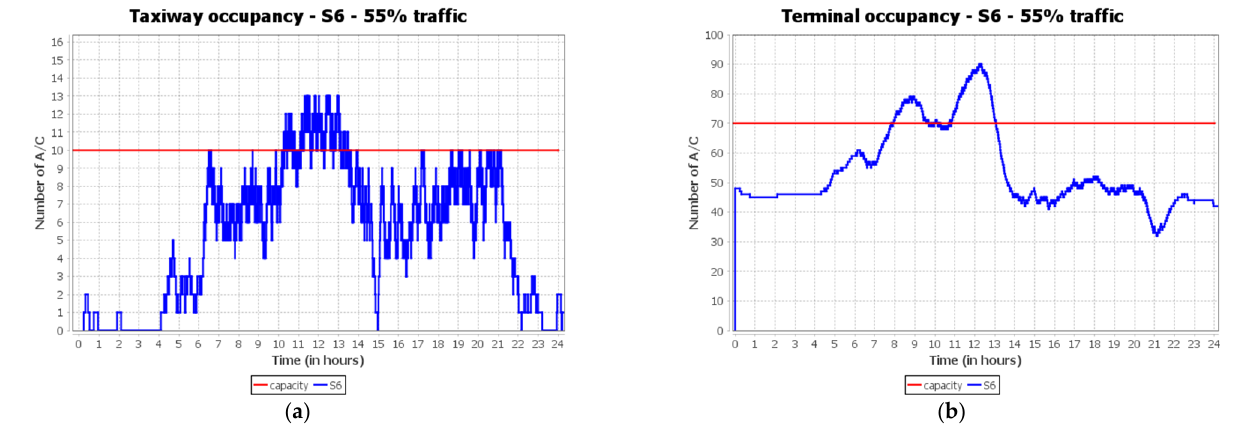
Figure 11. Taxiway ( a ) and terminal ( b ) occupancy scenario S6.